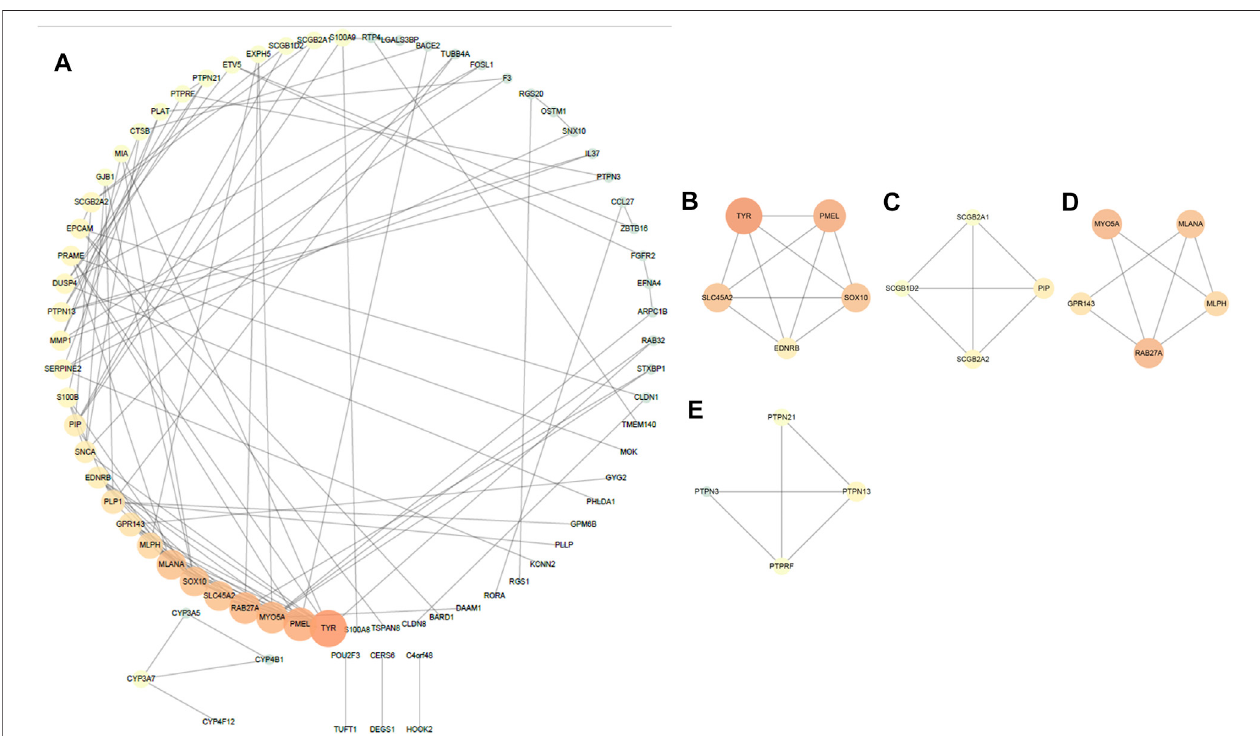
FIGURE 3 | Protein – protein interaction (PPI) network establishment and module analysis of the 135 DEGs. (A) PPI network with 75 nodes and 118 edges. (B – E) Four modules were identi fi ed by MCODE arithmetic.